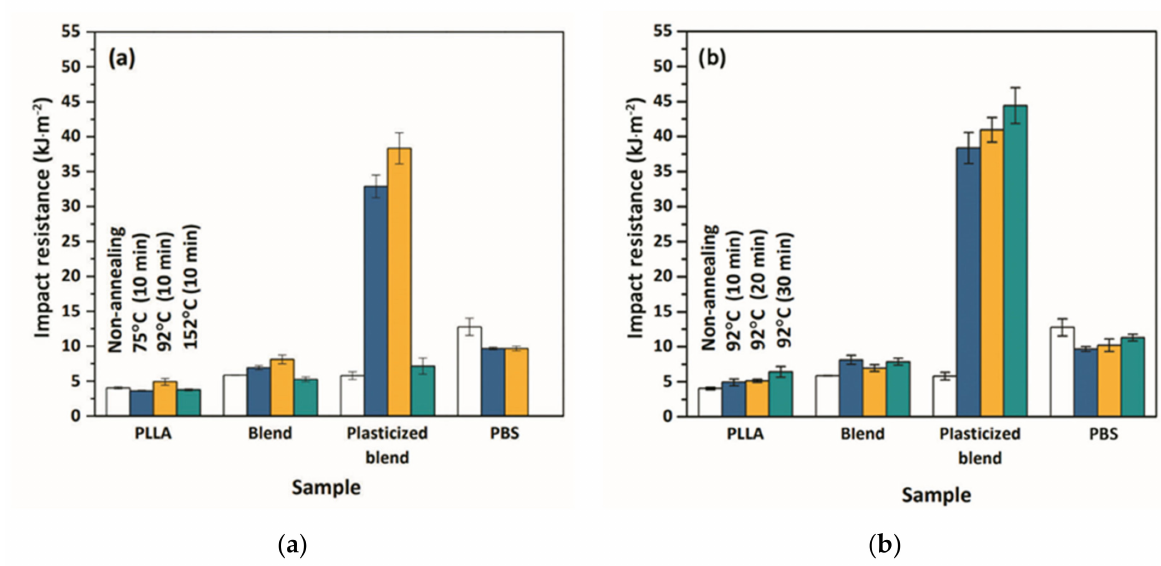
Figure 2. Effect of annealing temperatures ( a ), and duration ( b ) on notched Izod impact